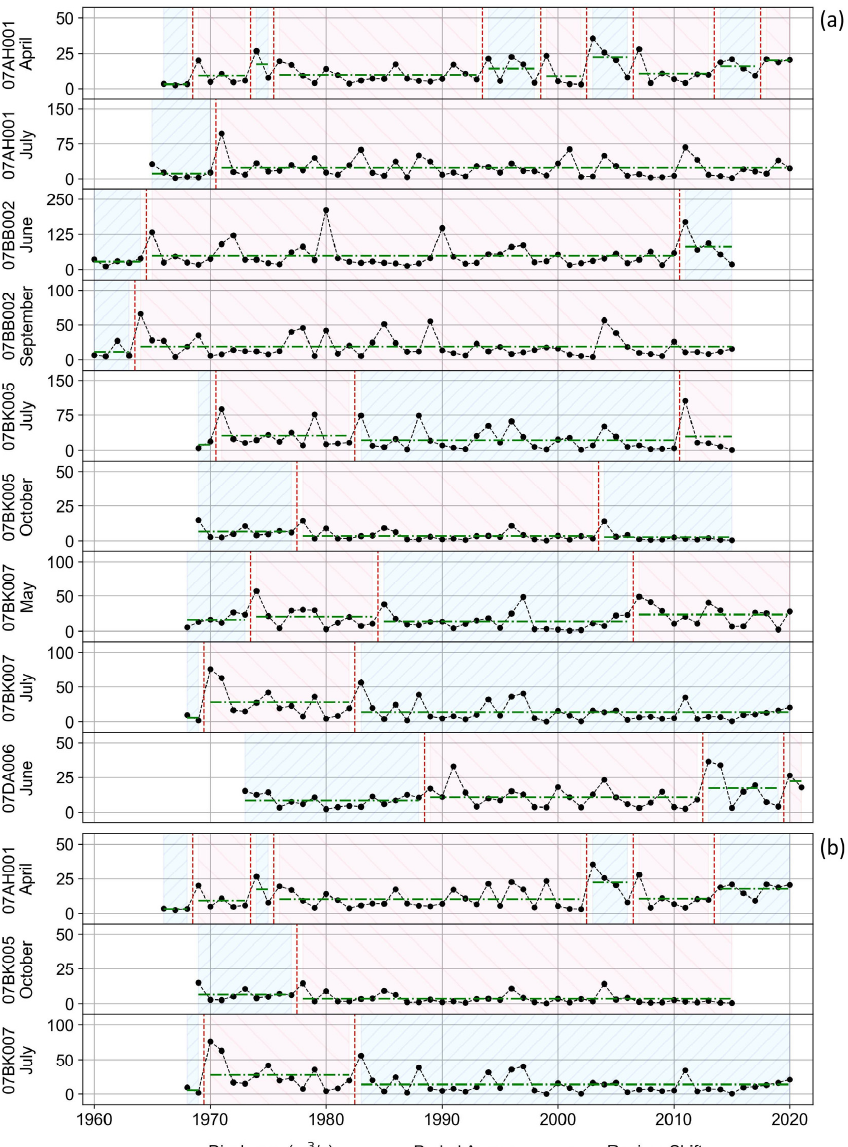
Figure 7. RSCD Results for warm and cold months using Growth Rate ( a ), Relative Difference ( b ), and a 30-year (1961–1990) period for calculating µ and σ , and ε thresholds from Table 2. The streamflow (m 3 /s) is shown on the y -axis in each panel. The use of red and blue shades aids in distinguishing between the di ff erent regimes. In the case of 07AH001 (April), RSCD-GR identi fi ed more periods than RSCD-RD. The same holds true for 07BK005 (October), where RSCD-GR identi fi ed more periods than RSCD-RD. Both methods generated the same results for 07BK007 (July). For the remaining months from Figure 6a, RSCD-GR identi fi ed those periods, yet RSCD-RD did not identify any. Correspondingly, we investigated 60 time series from the test set. In the nine time series, neither RSCD-RD nor RSCD-GR detected a regime shift. Identical regime shifts